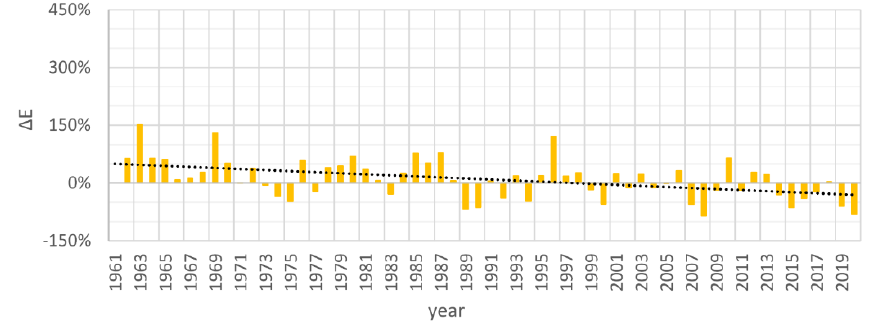
Figure 9. Relative energy for air humidification compared to 1961.